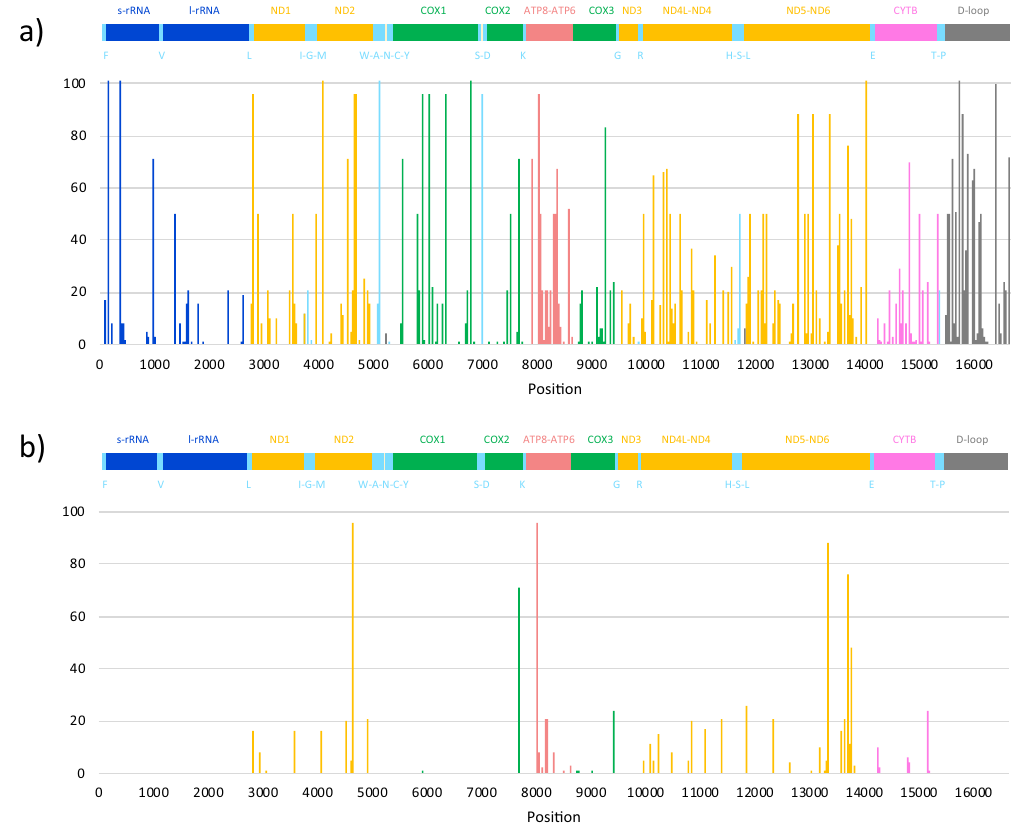
Figure 5. Numbers and locations of single-nucleotide variants (SNVs) detected in the mitochondrial genome. All detected ( a ) and non-synonymous substitutions ( b ) were